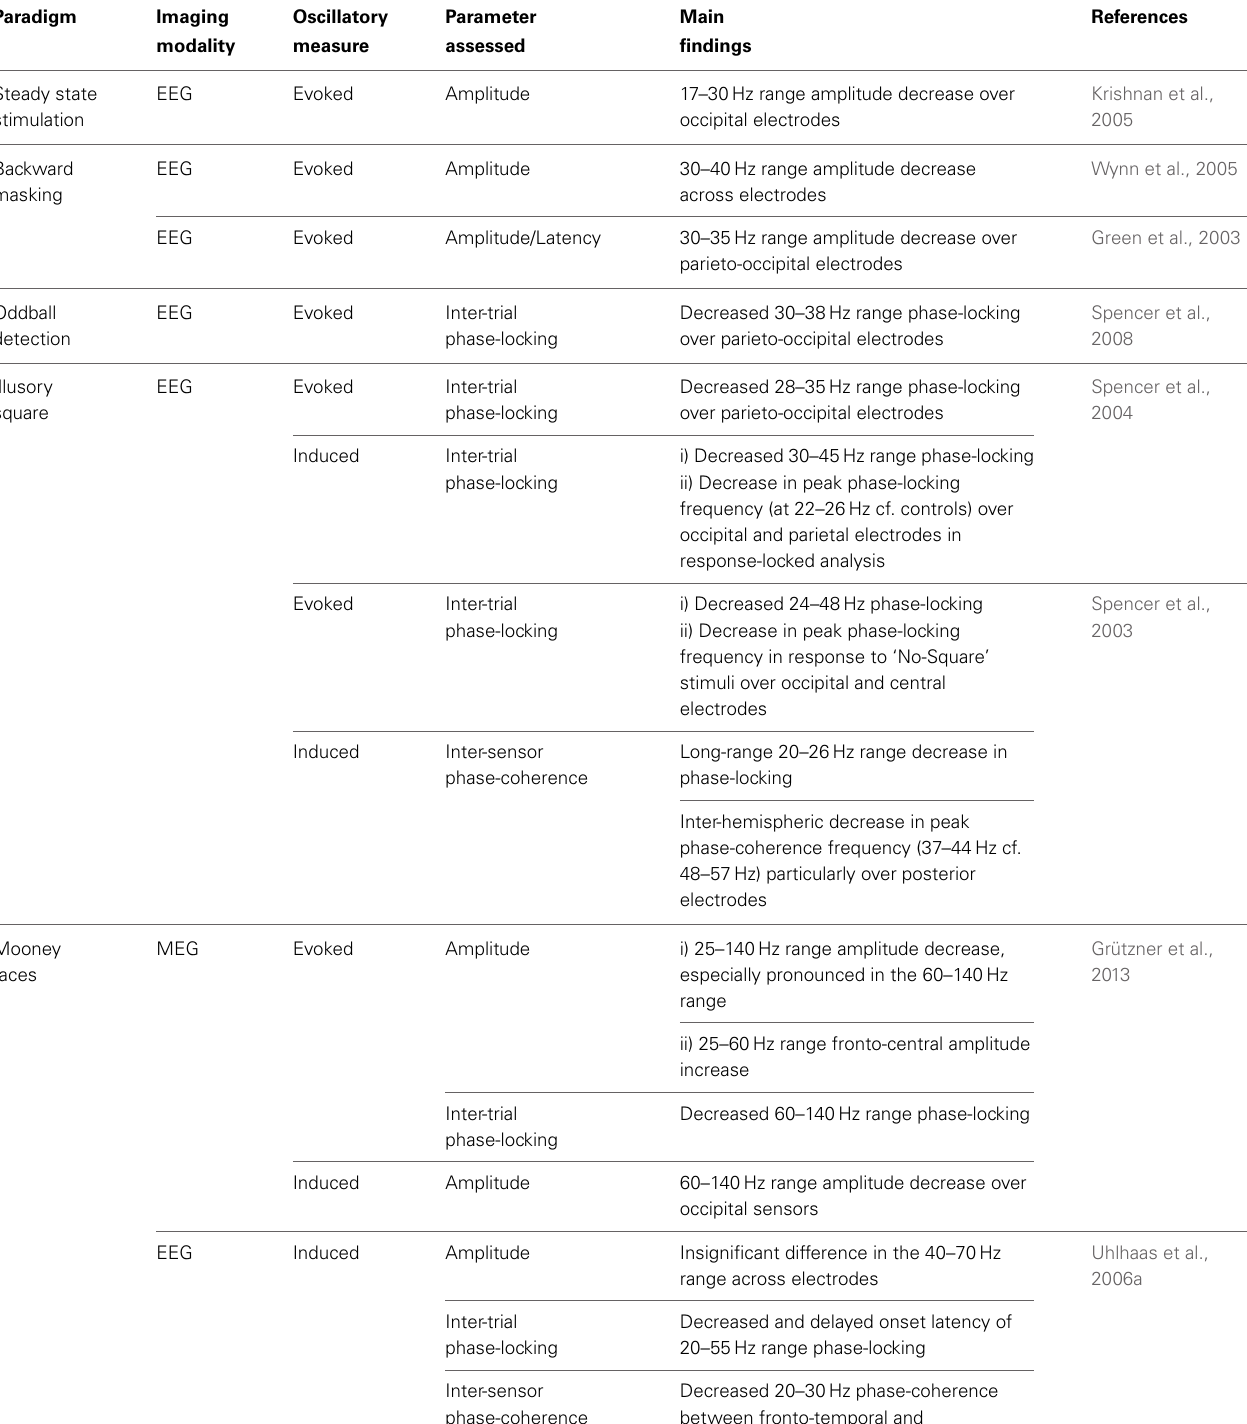
Table 1 | Summary of EEG/MEG studies investigating high-frequency neural oscillations in patients with chronic schizophrenia and healthy controls during visual perceptual